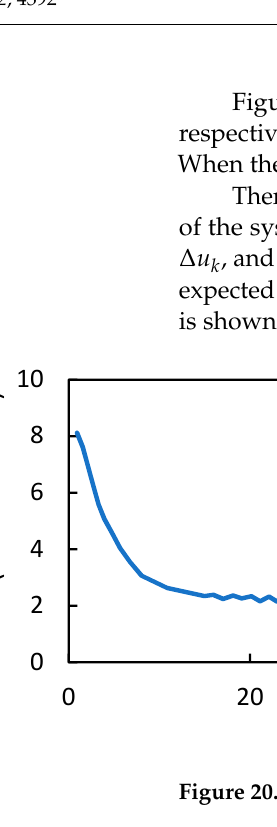
Table 2. Particle swarm optimization parameters.